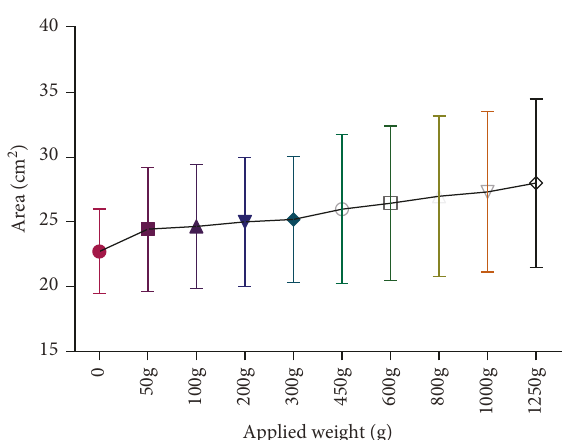
Figure 15: Behavior of the extensibility area (cm 2 ) of the emulgel with greater acceptability (F4).